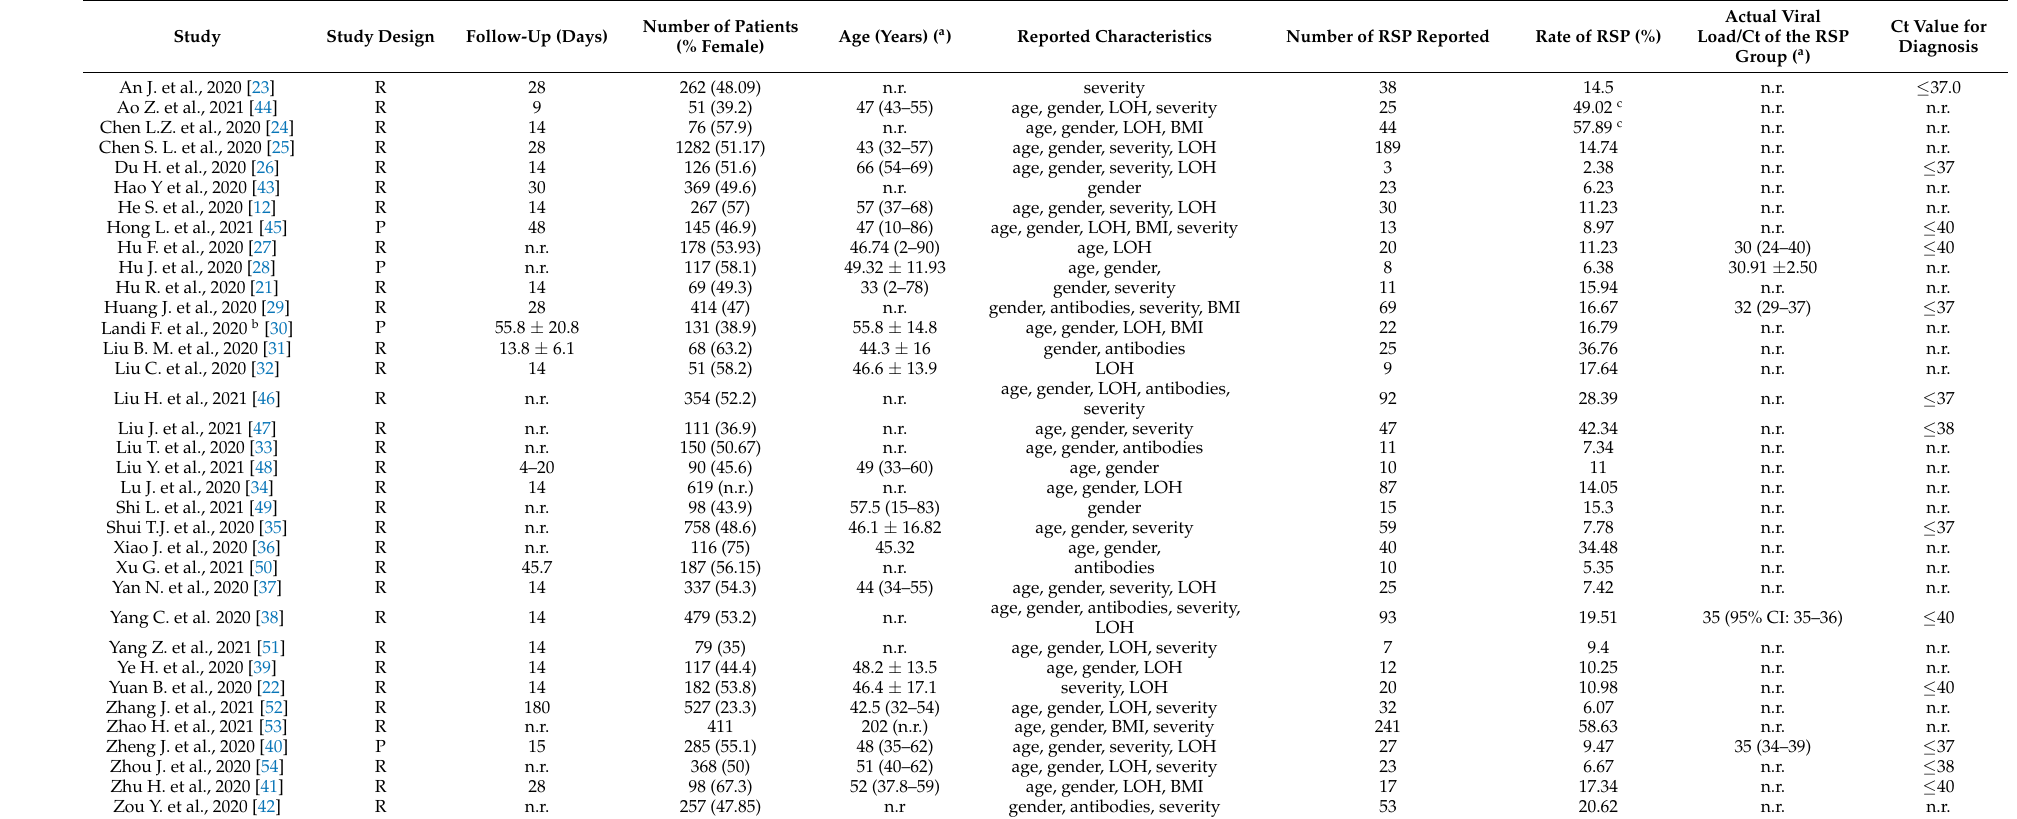
Table 1. Basic characteristics of the included